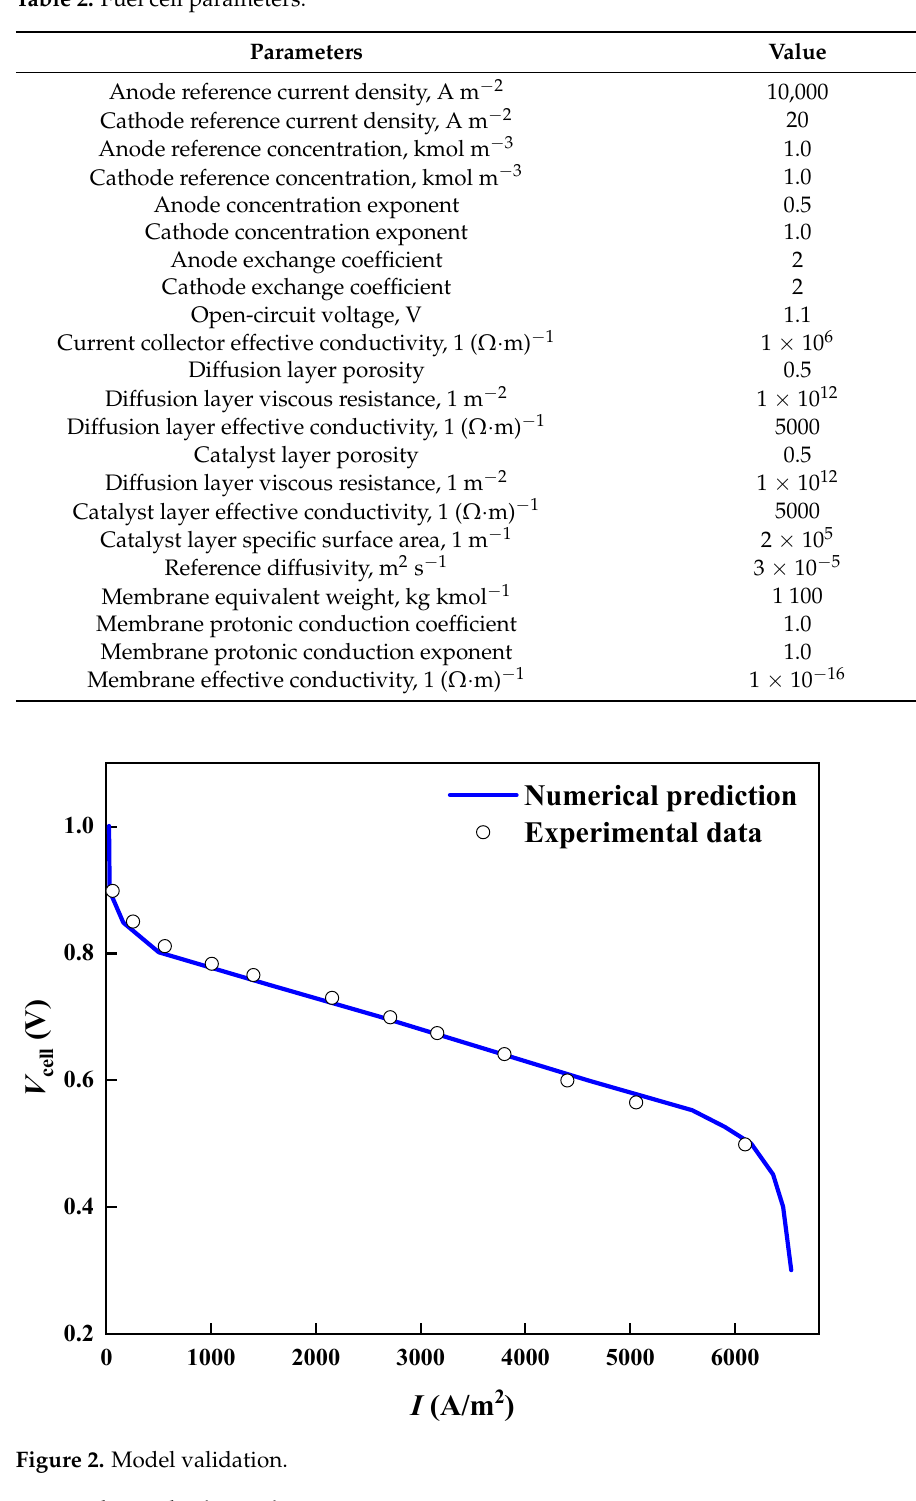
Table 2. Fuel cell parameters.